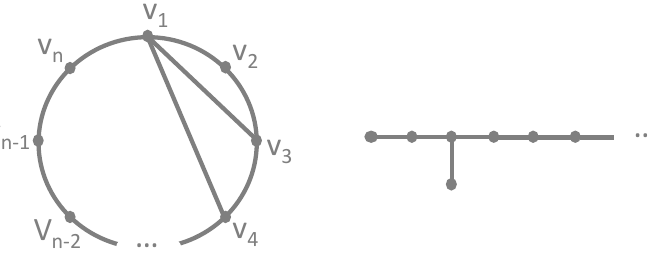
Figure 3. Graphs needing many iterations and the maximum number of